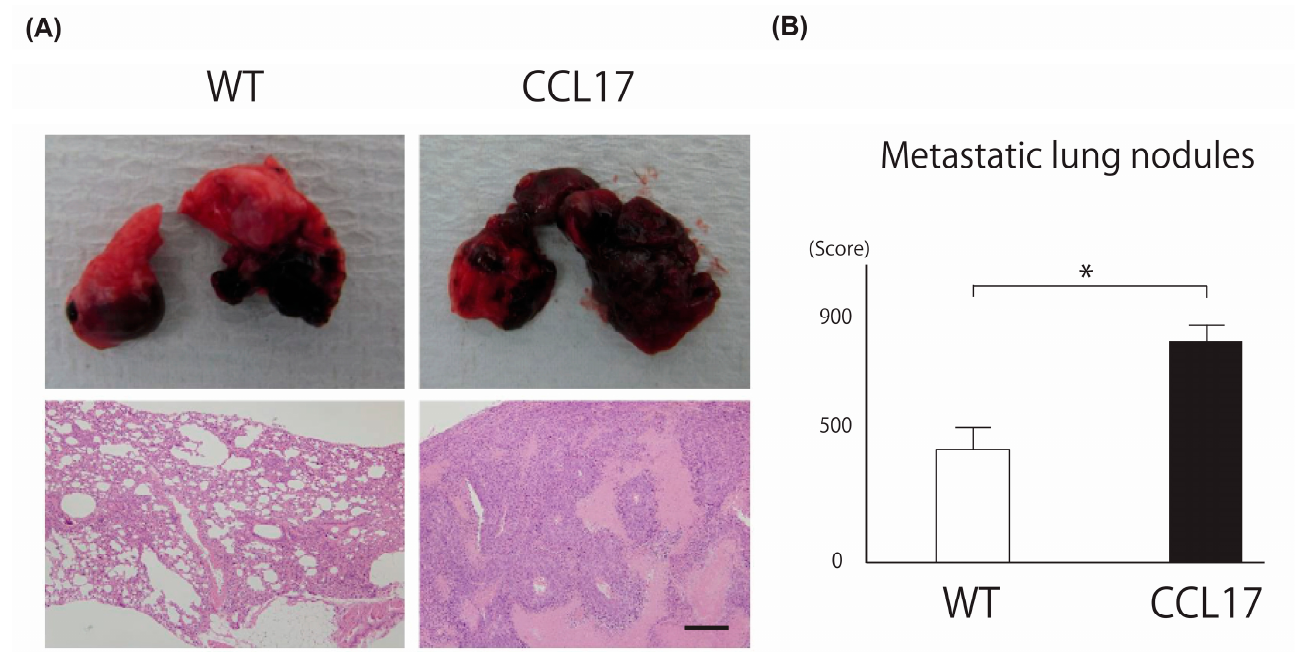
Figure 2. Metastatic lung tumor was promoted in CCL17 TG mice. Wild-type (WT) and CCL17 transgenic (TG) mice were treated with B16F1 melanoma cells injection intravenously. Metastatic lung area was evaluated 21 days after B16F1 cells were injected intravenously. ( A ) Phenotypical manifestation of lungs from WT and CCL17 TG mice 21 days after application of B16F1 cells injection (upper panel). Representative pathological images of lung metastatic clones in WT mice and CCL17 TG mice are shown (lower panel). Original magnification ×100; scale bar = 200 μ m. ( B ) Metastatic lung area was significantly larger in CCL17 TG mice compared with that in WT mice. Metastatic lung nodules were evaluated by calculating colony areas as described following. When >60% of the section was occupied with tumor, the colony number was defined as 1000. Each section of the three lobes of the right lung was investigated. Data are presented as mean ± SEM of three independent experiments ( n = 6 for each group). * p < 0.05 WT versus CCL17 TG mice.